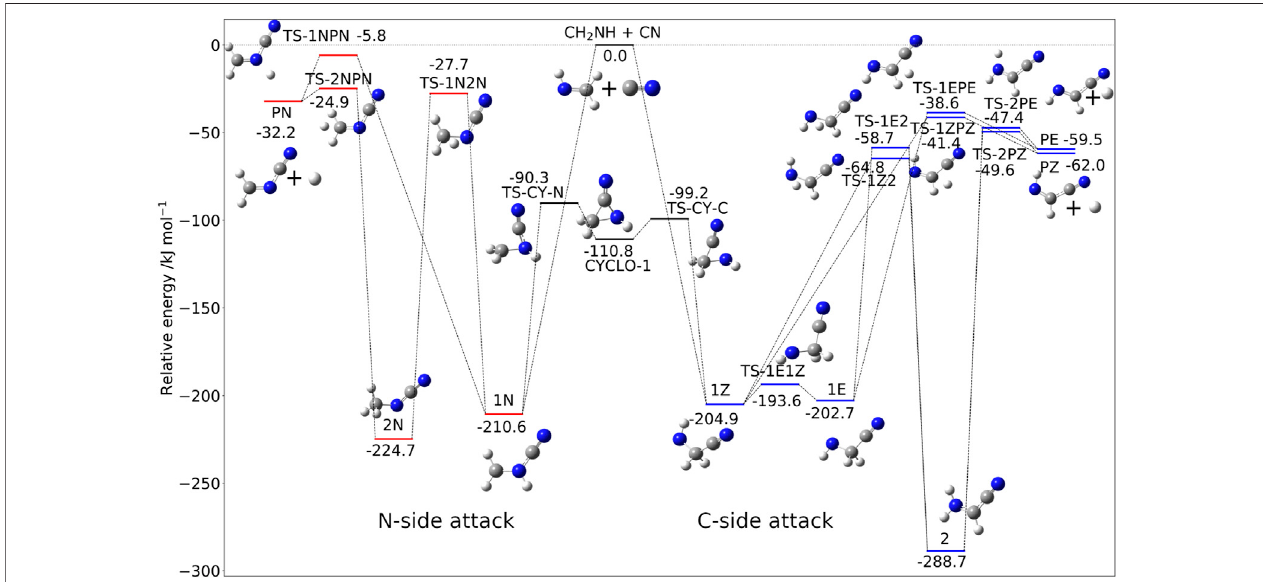
FIGURE 5 | The CH 2 NH + CN reactive PES: Structures and relative jun-Cheap electronic energies (kJ/mol) of the stationary points ruling the addition/elimination channel.